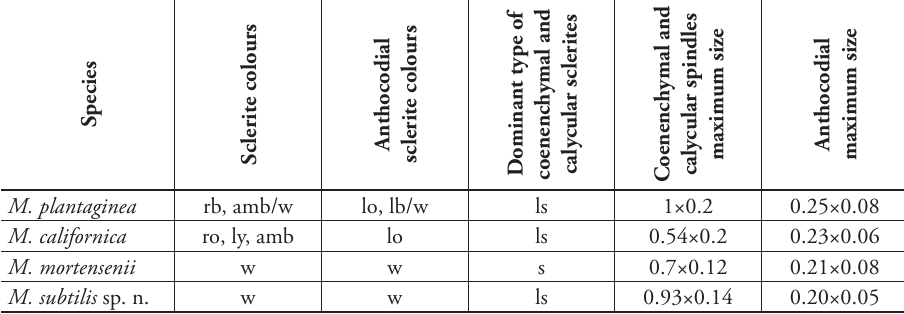
Colours: amb, amber; lb, light brown; lo, light orange; rb, reddish brown; ro, reddish orange; w, white, colourless. Type of coenenchymal and calycular sclerites: ls, leaf-like spindle; s,